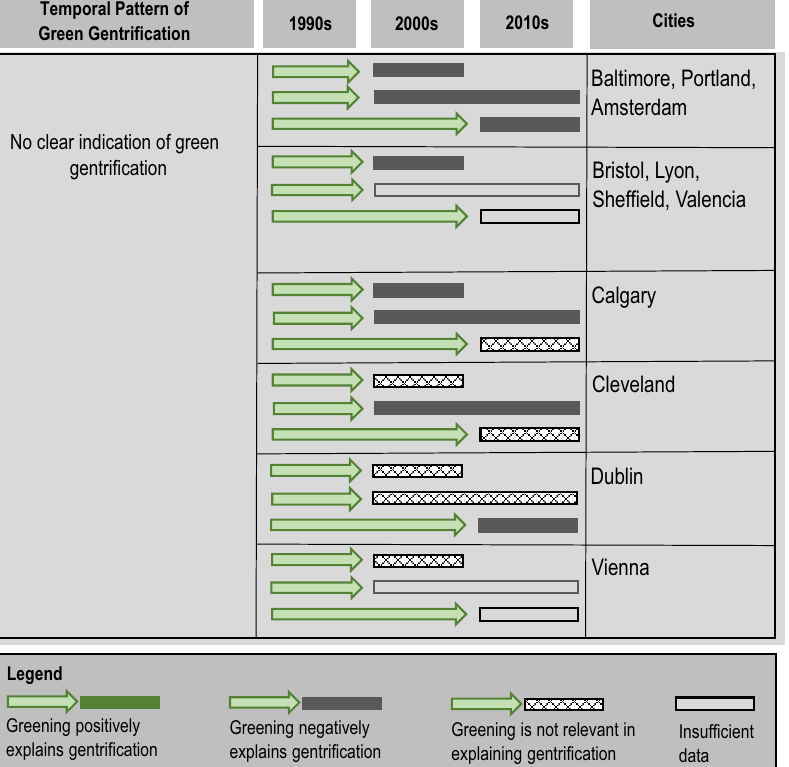
Fig. 3 Cities with no clear patterns of green gentri fi cation. These patterns show cities where greening is likely either a negative or not a relevant predictor of gentri fi cation. For these cities, new development, new transit or spatial location are other likely relevant drivers of gentri fi cation.